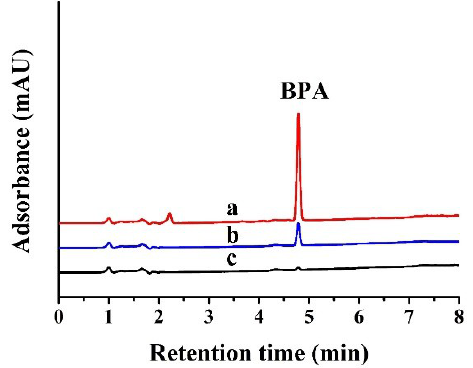
Figure 9. The HPLC-DAD chromatograms of BPA obtained from: ( a ) 2 mL eluent after elution; ( b ) direct injection of the BPA solution; ( c ) the BPA solution after adsorption; 50 mg adsorbents in 10.0 mL solution (1 mg/L BPA) The optimal conditions were used.